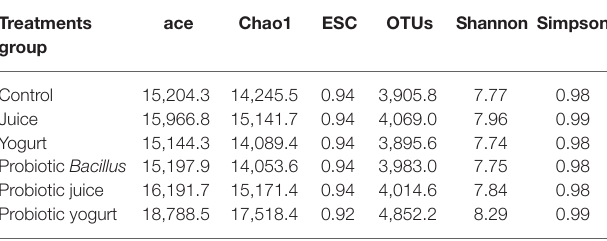
TABLE 3 | Alpha-diversity metrics (ace, Chao1, Good’s estimated sample coverage (ESC), OTUs, Shannon and Simpson indices) obtained for fecal samples of healthy Wistar male rats after 21 days of administration of probiotic yogurt and probiotic juice inferred from the sequencing of 16S V3–V4 amplicons.